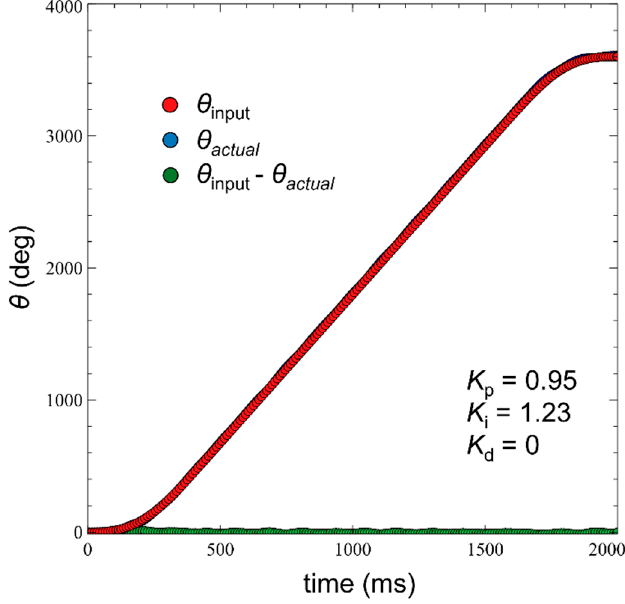
Figure 4. Response of the propulsion motor with PID control.